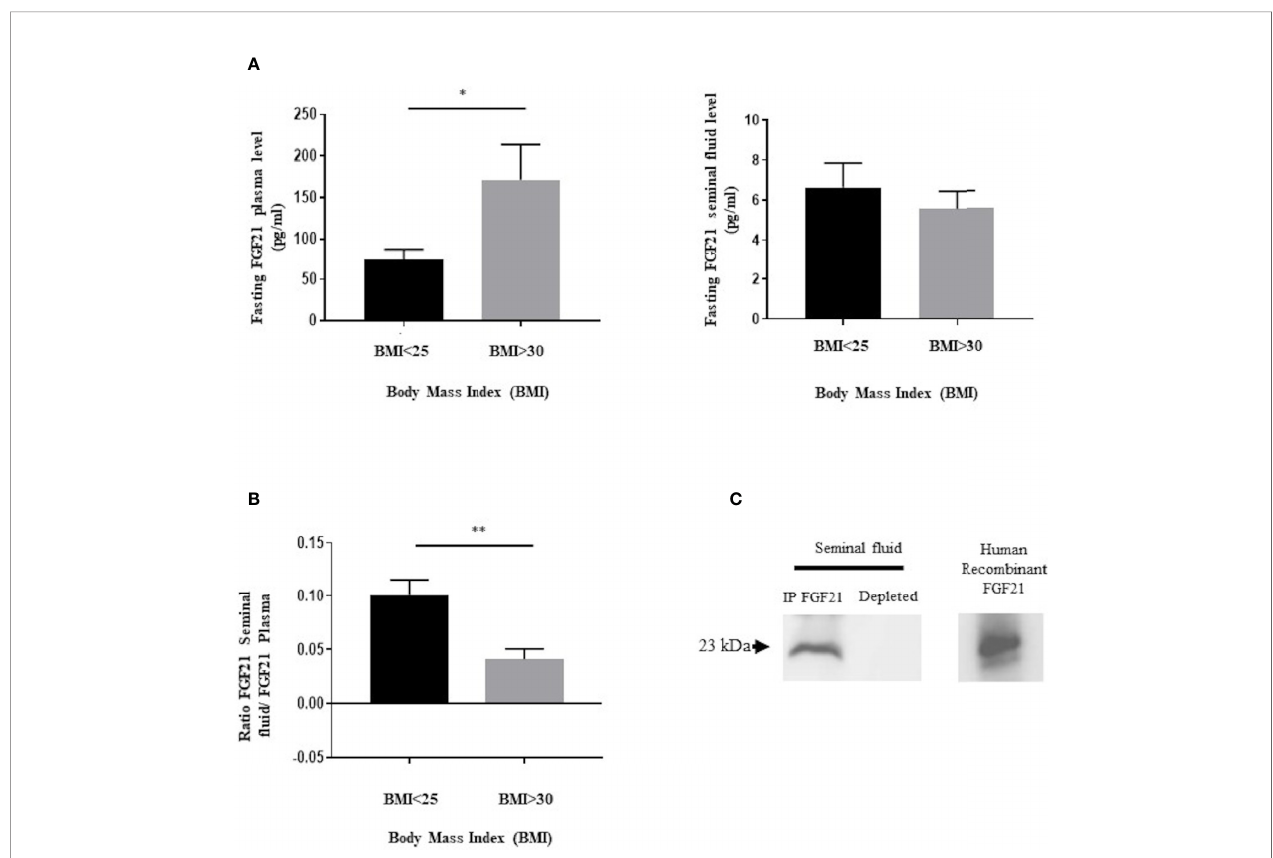
FIGURE 1 | Presence of FGF21 in human plasma and seminal fl uid. (A) FGF21 was determined, from two groups of fasting patients, in plasma (n = 10/BMI group) and in seminal fl uid (n = 12/BMI group), in function of their body mass index (BMI). Control corresponding to a BMI ≤ 25 kg/m 2 , and obesity corresponding to a BMI ≥ 30 kg/m 2 . (B) Ratio of fasting FGF21 level between seminal fl uid and plasma in the two groups of patients. (C) Immunoblot of a pool of human seminal fl uid protein extracts (400 m g protein per sample) after immunoprecipitation with the FGF21 polyclonal antibody. Human recombinant FGF21 was loaded as the control to con fi rm the molecular weight of the immunoprecipitated FGF21 protein. *p < 0.05, **p <